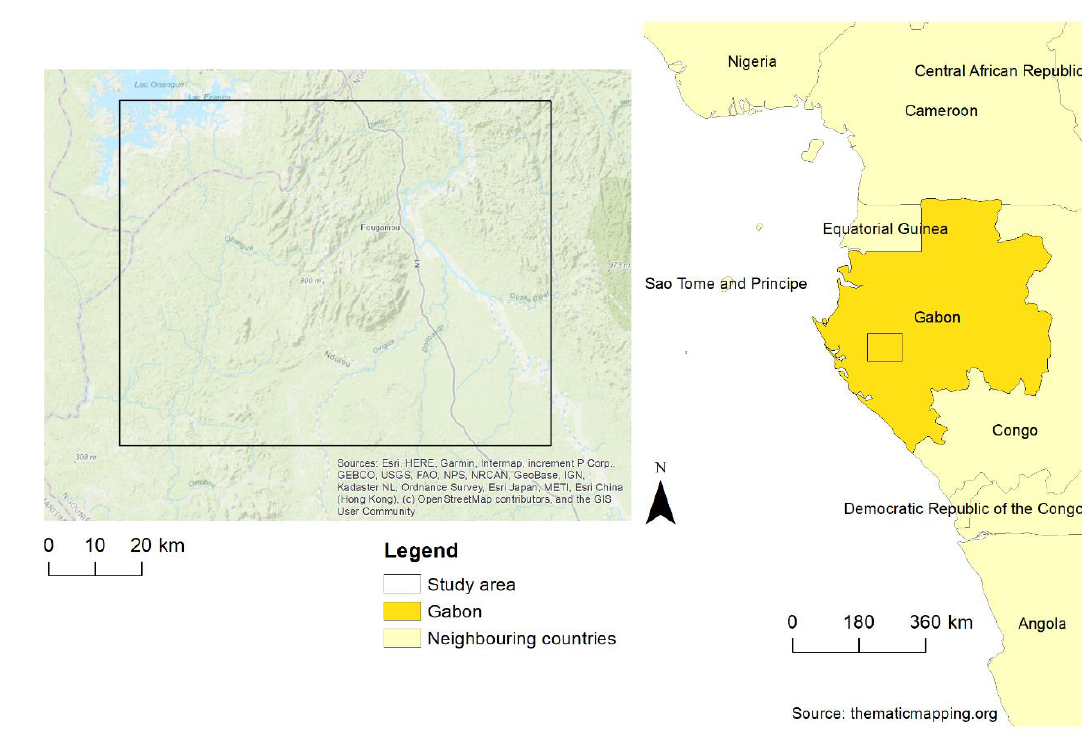
Figure 2. Test site Gabon.